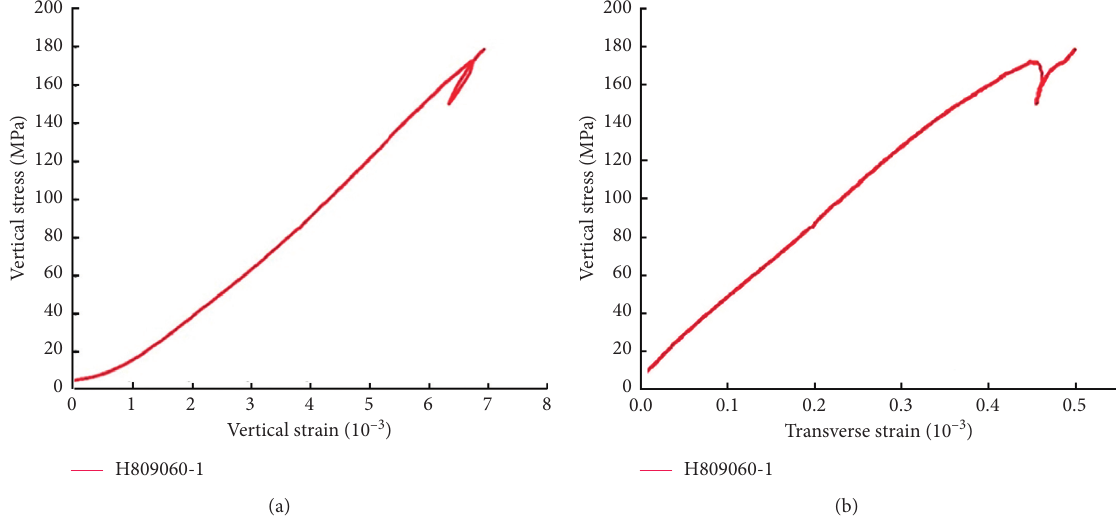
Figure 12: Stress versus strain curves of the cubic granite samples. (a) Vertical stress-vertical strain curve of the granite sample. (b) Vertical stress-strain curve of the granite